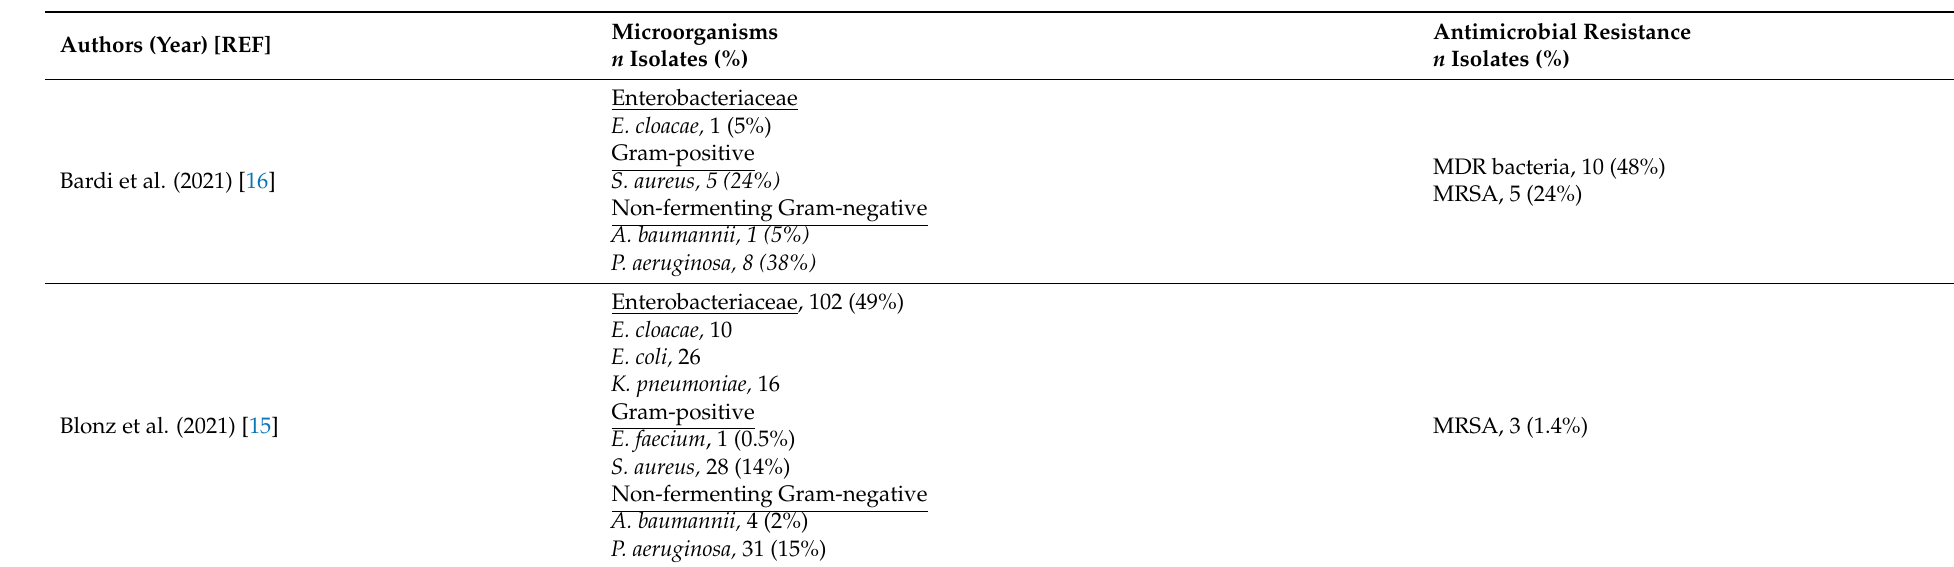
Table 2. Main microorganisms isolated in patients with COVID-19 and VAP. The table shows the number of isolates containing E. faecium , S. aureus , K. pneumonia , A. baumannii, P. aeruginosa , Enterobater spp., and E. coli in patients with COVID-19 and VAP per each included study, if available. The microorganisms are sorted by families. Data are shown as numbers and percentages. All the percentages are calculated on the total number of isolates, when available. When data on these individual microorganisms were not available, we reported them as grouped by the